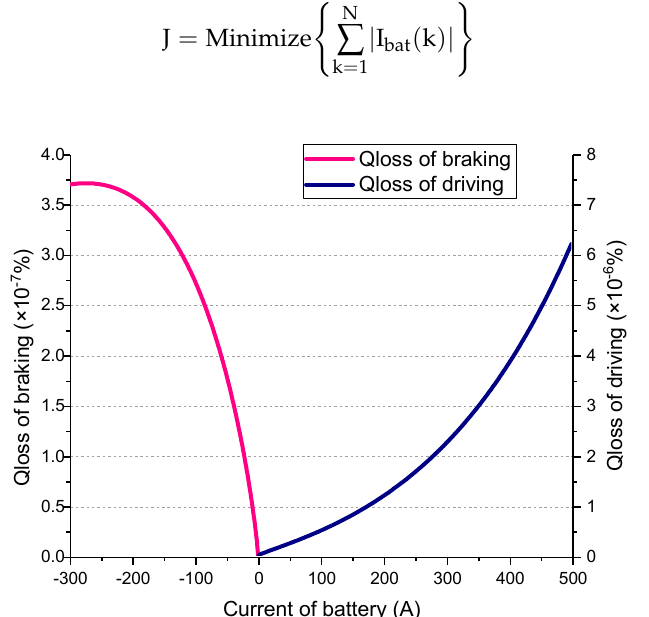
Figure 7. The relationship between battery charge/discharge current I bat and battery degradation percentage Q loss .